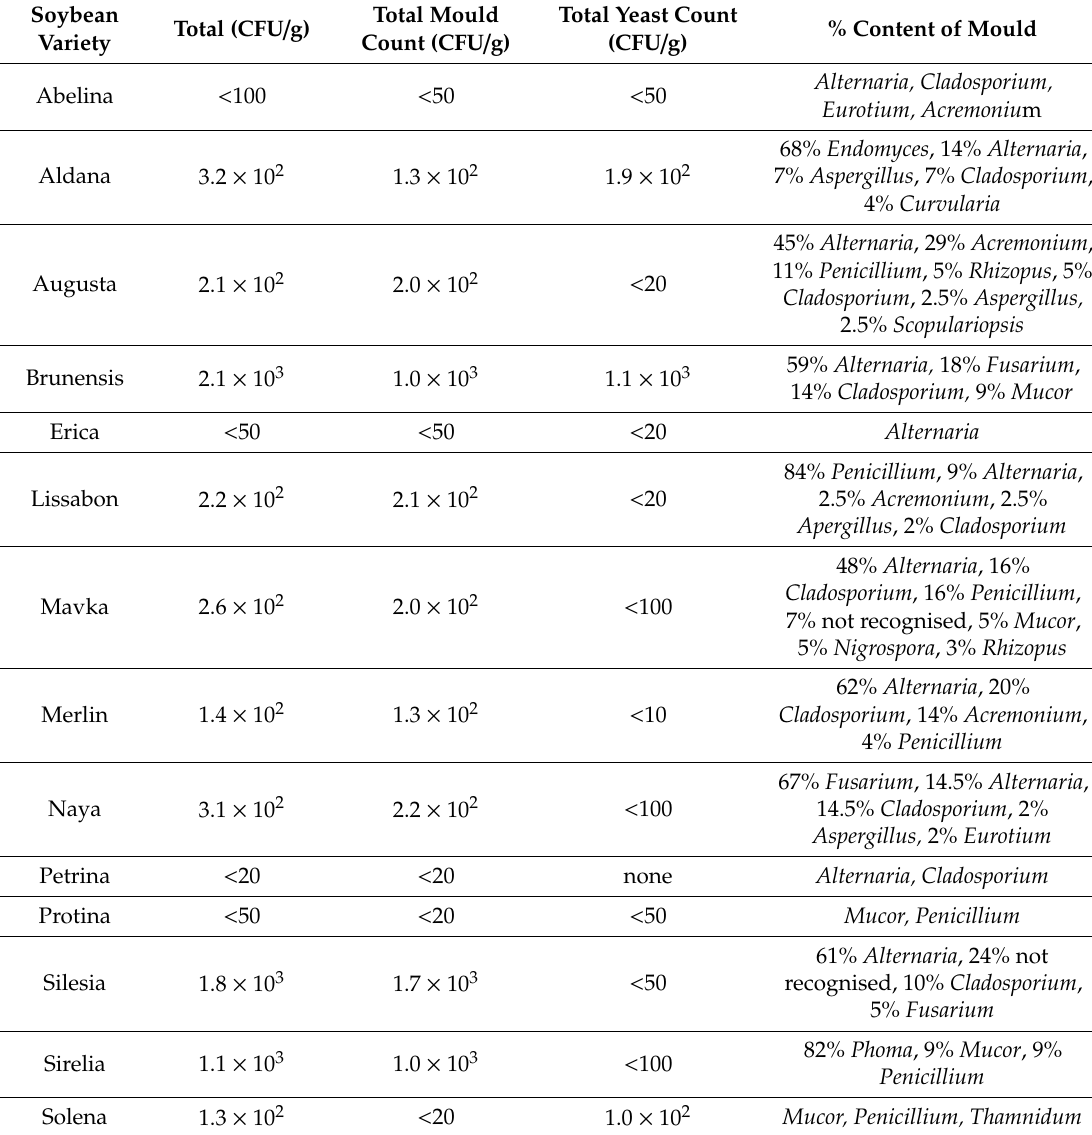
Table 6. Contents of mould groups in selected analysed soy